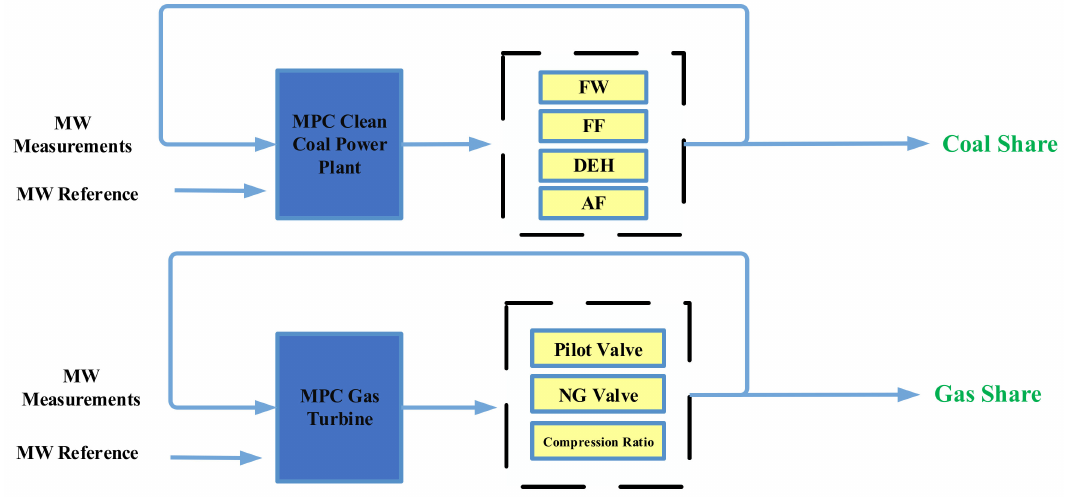
Figure 4. The advancement control strategy with